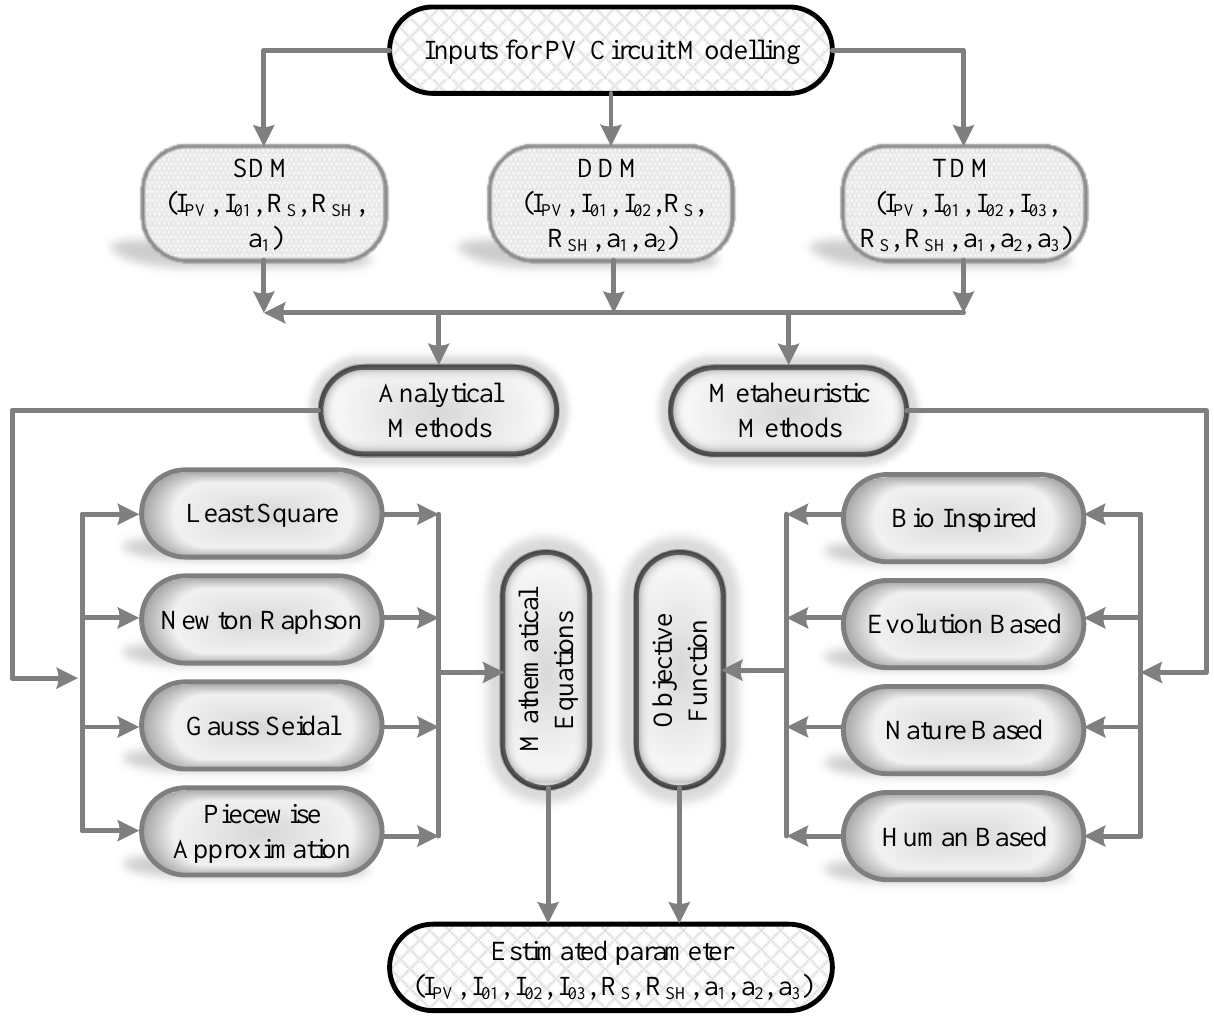
Figure 4. Methods used in PV parameter extraction.